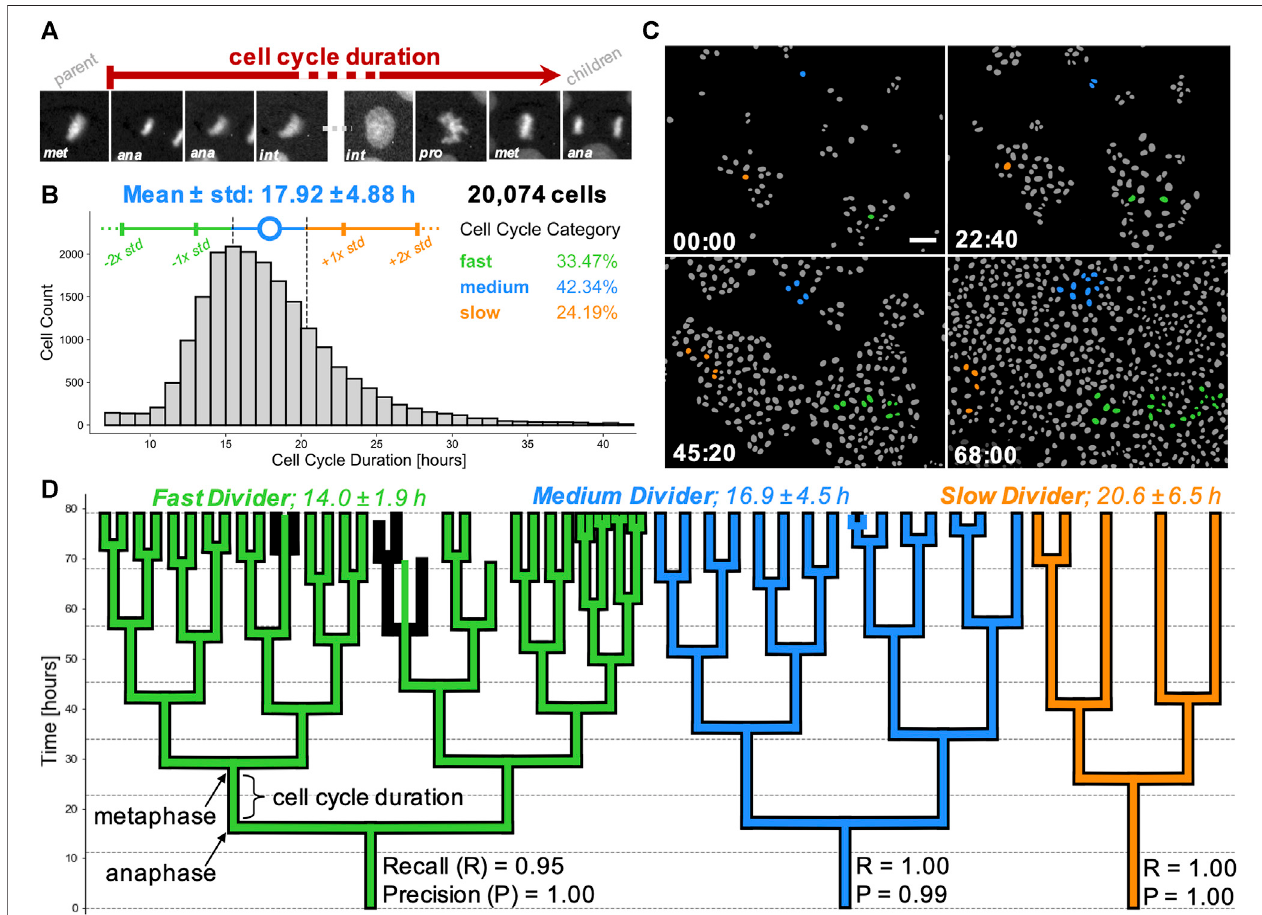
FIGURE7| Cellcyclingheterogeneityandcolonyexpansioncapacitywithinsinglecellclones. (A) Cellcycleduration,de fi nedhereasthetimeelapsedbetweentwo subsequentanaphases,fromthemitosisofreferencecell ’ sparent( fi rstimagepatch)todivisionintotwochildrencells(lastimagepatch).Scalebar (cid:1) 5 µm. (B) Calculated cell cycle duration distribution over the pooled MDCK live-cell imaging dataset from 5,325 unique lineage trees. Error bars (colored vertical bars) show one and two standard deviations around the mean (blue circle) of tracked cells for generational depths spanning 1 to 6 (generations #0 and #7 were excluded as those corresponded to the tree root of leaf cells). Cell categorisation into fast (green), medium (blue) and slow (orange) dividers is depicted as below, within or above 1/2 standarddeviationawayfromthemean(dashedblackverticallines),respectively.Percentagesofsinglecellsbelongingtoeachcategoryarestated. (C) Sequenceoffour colourised binary masks with segmented individual cells (grey) on background (black), highlighting cell proliferation from the start (top left) to the end (bottom right) of a representative movie. Time in hh:mm is indicated in the bottom left corner. Founder cells and progeny corresponding to slow (orange), medium (blue) and fast (green) dividers are highlighted. Scale bar (cid:1) 50 µm. (D) 2D representations of typical lineage trees captured from data, showing slow (orange), medium (blue) and fast (green) dividingcells.Computer-generatedtracks(colour)areoverlaidonhuman-reconstructedgroundtruthtrajectories(black).Individualrecallandprecisionscoresareshown for each lineage tree, with vertical branch lengths corresponding to intermitotic time (cell cycle duration) elapsed between the fi rst post-division frame (anaphase) to the last frame prior tothe next cell division (metaphase). Trees illustrate anerror-freetracking (orange tree) and two types of tracking errors, i.e. falsely identi fi ed mitosis(blue tree) and missed mitotic event (green